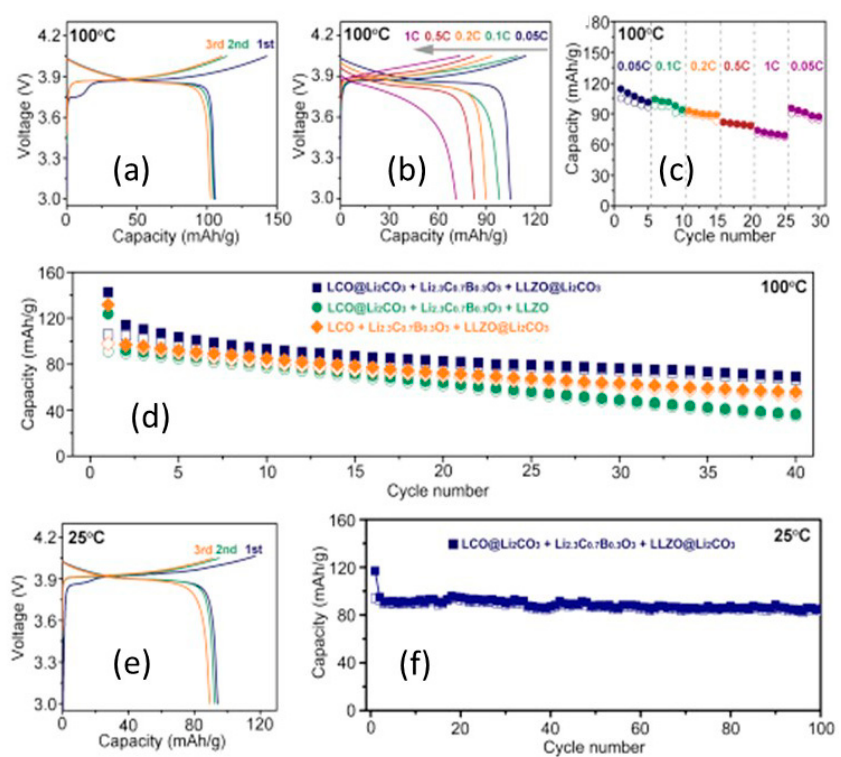
Figure 27. ( a ) Charge–discharge profiles of the interphase-engineered all-ceramic Li| Li 6.4 La 3 Zr 1.4 Ta 0.6 O 12 |LiCoO 2 (Li|LLZO|LCO) cell for the first three cycles at 0.05C and 100 °C. ( b ) Charge–discharge profiles of the interphase-engineered all-ceramic Li|LLZO|LCO cell at different current rates in the range of 0.05–1C at 100 °C. The profiles at the different rates were obtained using fresh cells after one activation cycle at 0.05C. ( c ) Rate performance of the interphase-engineered all-ceramic Li|LLZO|LCO cell at 100 °C. The capacities at the different current rates were obtained using fresh cells, and each cell is represented using a different color. ( d ) Cycling performance of the interphase-engineered all-ceramic Li|LLZO|LCO cell at 0.05 C and 100 °C. The cycling performances of all-ceramic Li|LLZO|LCO cells with cathode composites consisting of uncoated LCO (LCO + Li 2.3 C 0.7 B 0.3 O 3 + LLZO@Li 2 CO 3 ) and uncoated LLZO (LCO@Li 2 CO 3 + Li 2.3 C 0.7 B 0.3 O 3 + LLZO) are also included. ( e ) Charge–discharge profiles of the interphase-engineered all-ceramic Li|LLZO|LCO cell for the first three cycles at 0.05 C and 25 °C. ( f ) Cycling performance of the interphase-engineered all-ceramic Li|LLZO|LCO cell at 0.05C and 25 °C. The specific capacity was calculated based on the weight of LCO in the cathode composite. Reproduced with permission from [357]. Copyright 2018 Elsevier.